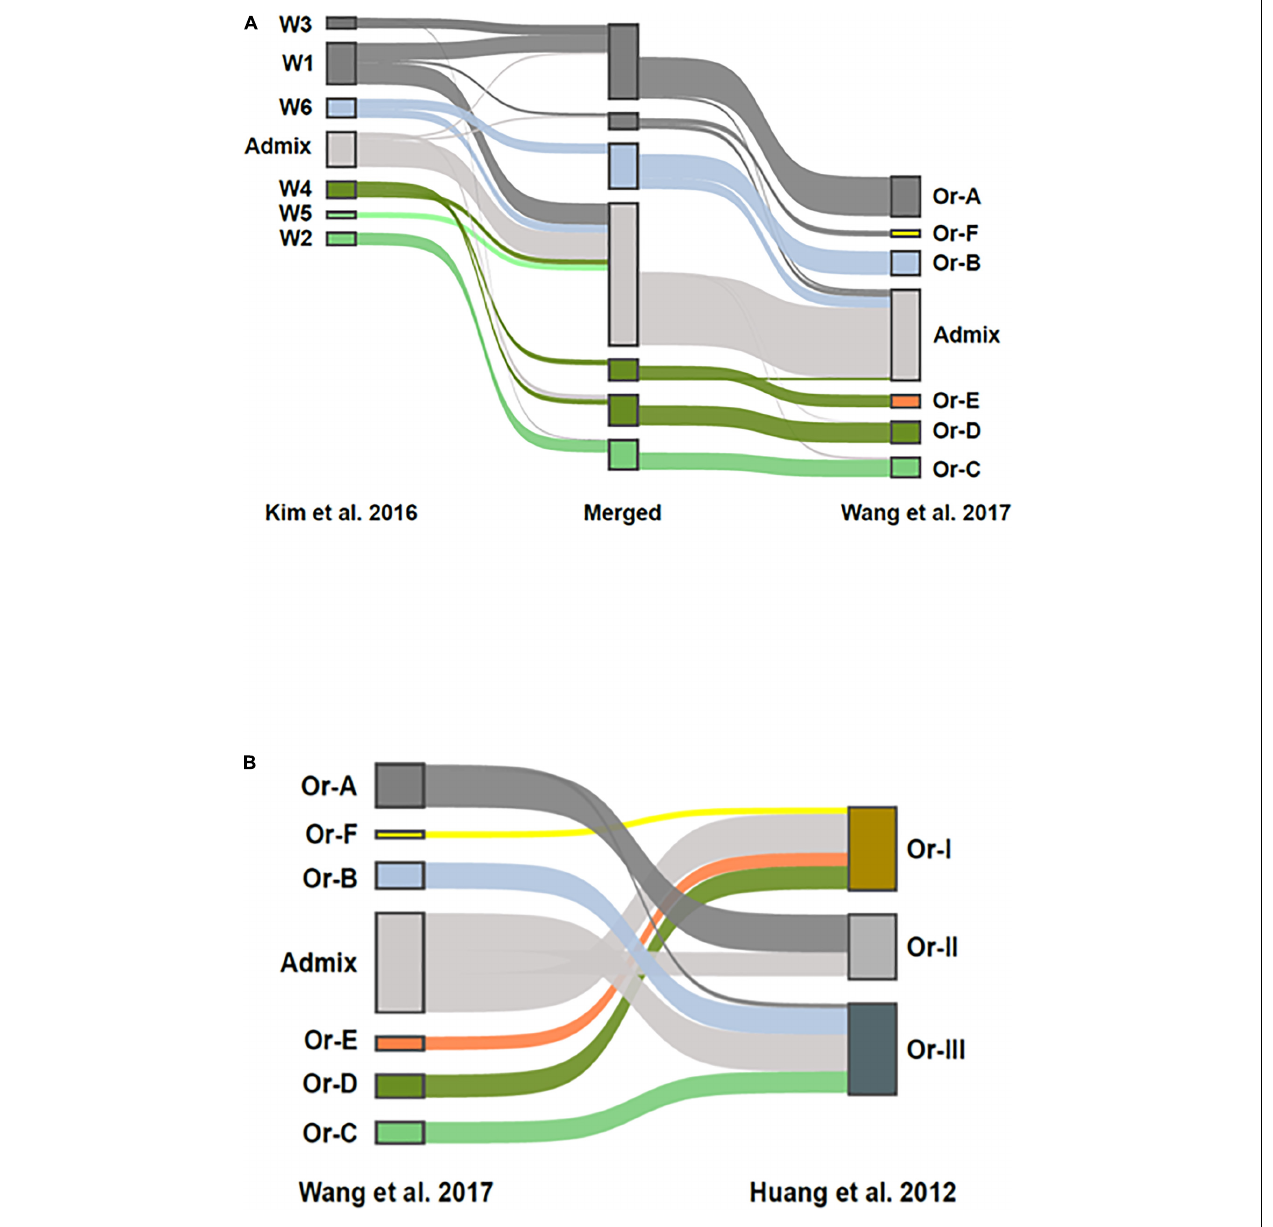
FIGURE 4 | Comparison of ORSC genotypic subpopulations reported by Kim et al. (2016) based on 286 ORSC accessions to those reported by Wang et al. (2017) and Huang et al. (2012) based on 446 ORSC accessions. (A) Population structure assignments in a merged SNP dataset consisting of accessions from two ORSC collections. On the left side are the accessions from Kim et al. (2016), on the right are accessions from the analysis by Wang et al. (2017). In the center is a merged set with group assignments at K = 7. Ribbons connect the group assignments of the merged accessions with their group assignments in the respective ORSC collections (B) Comparison of the three subpopulations originally identified by Huang et al. (2012) to the six subpopulations and admixed group identified by Wang et al. (2017) when reanalyzing the same genotypic data. The inclusion of aus -like ( Or-E ) and indica -like ( Or-F ) accessions in Or-I and japonica -like ( Or-B ) accessions in Or-III as reported by Huang et al. (2012) is